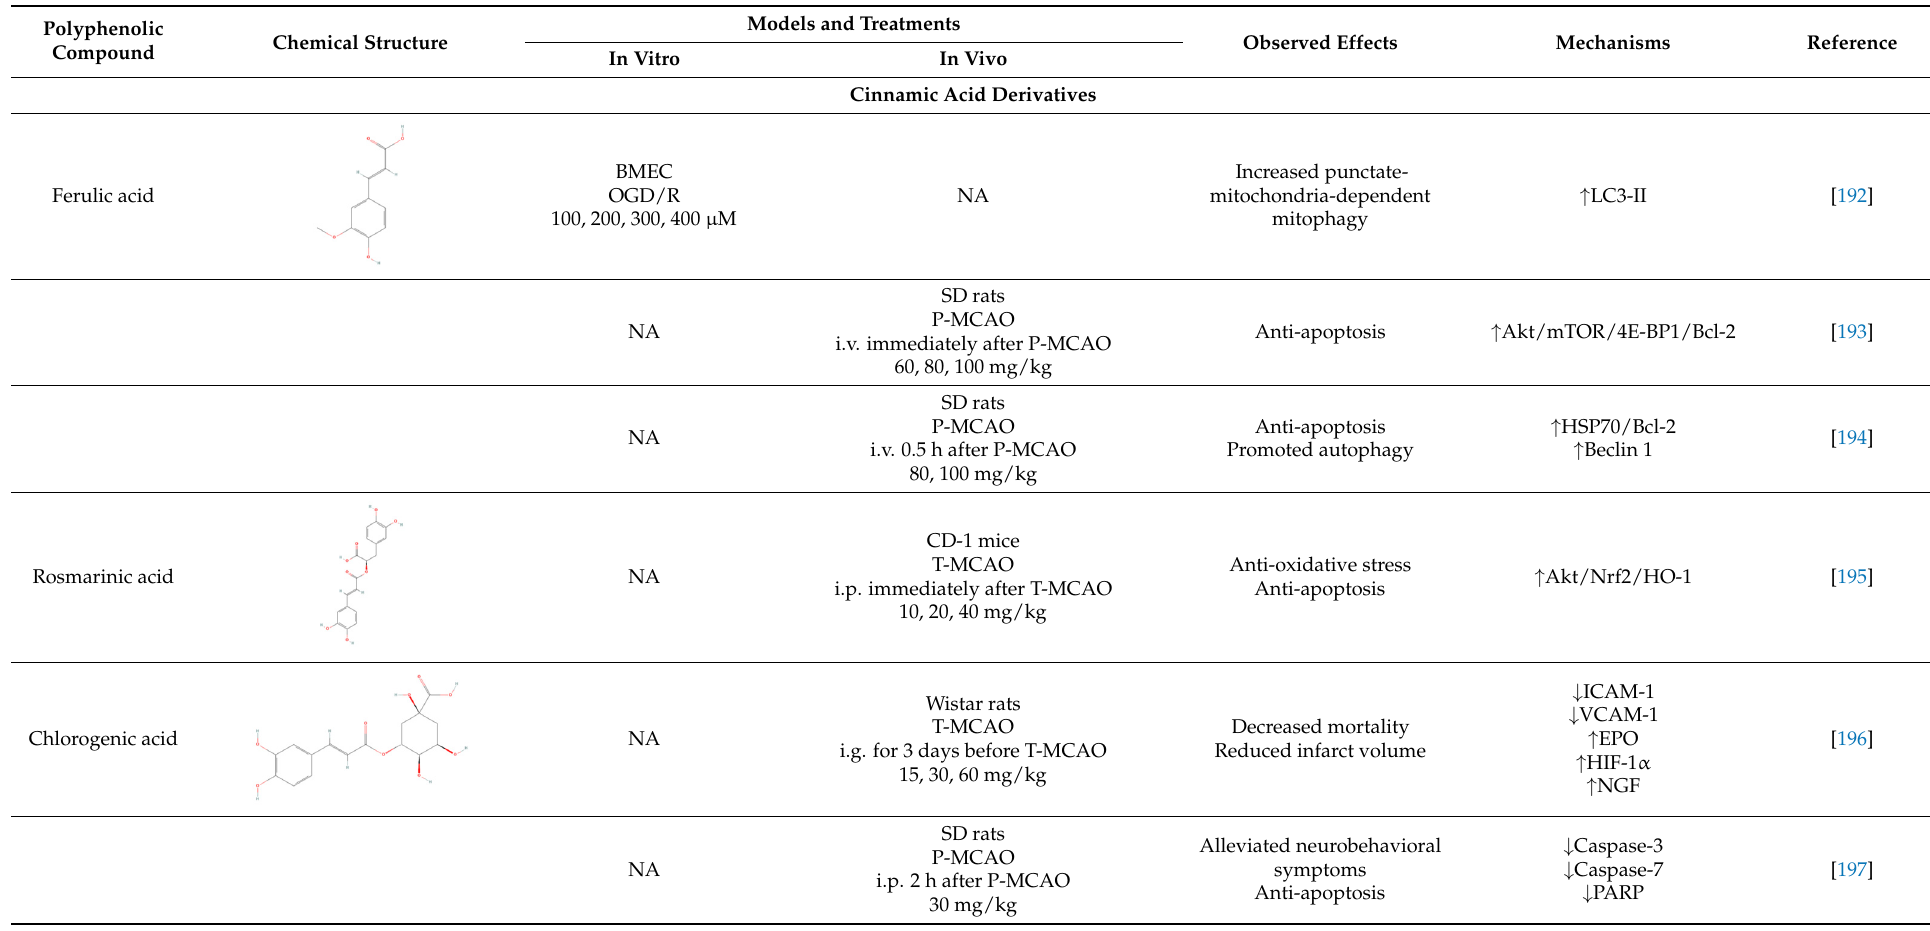
Table 2. Summary of recent studies on the anti-IS effects of phenolic acids.